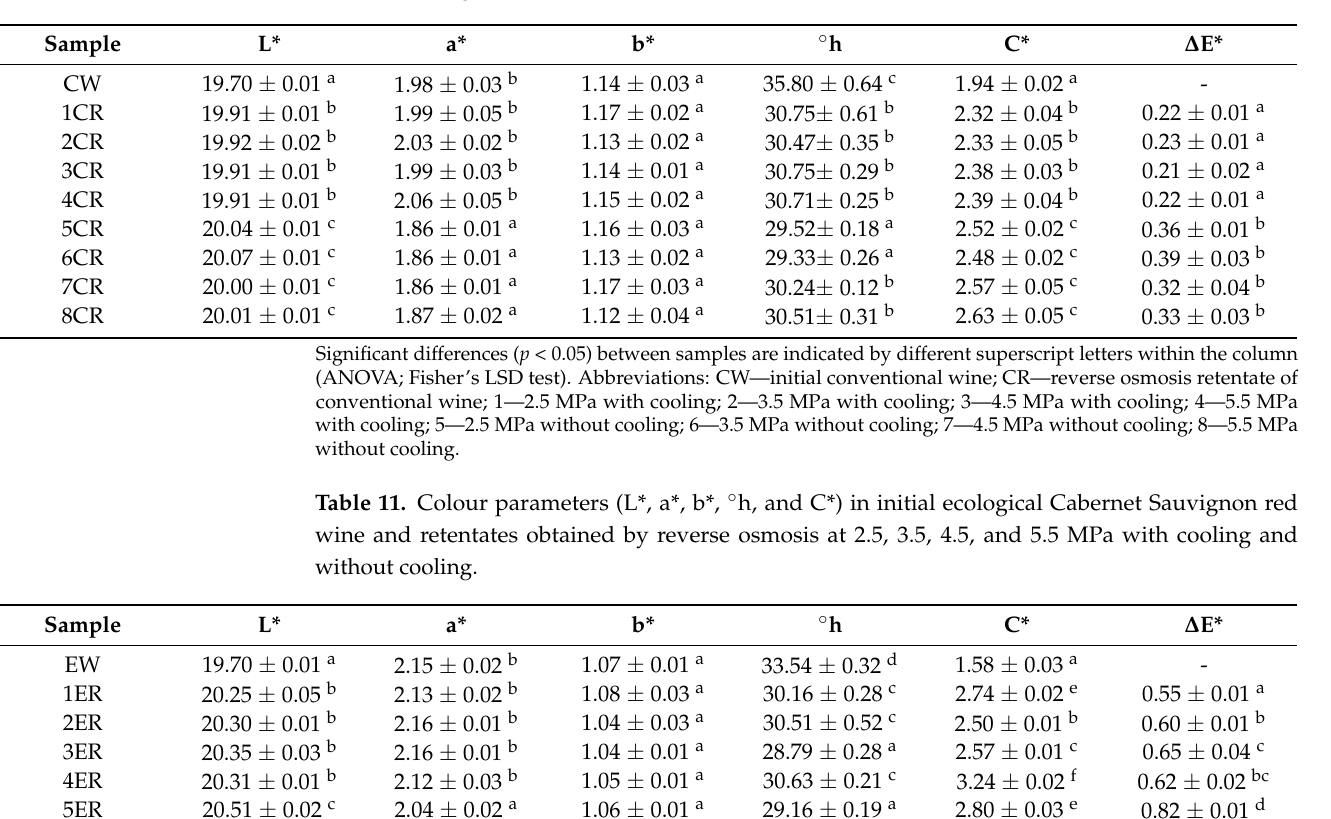
Table 10. Colour parameters (L*, a*, b*, ◦ h, and C*) in initial conventional Cabernet Sauvignon red wine and retentates obtained by reverse osmosis at 2.5, 3.5, 4.5, and 5.5 MPa with cooling and without cooling.